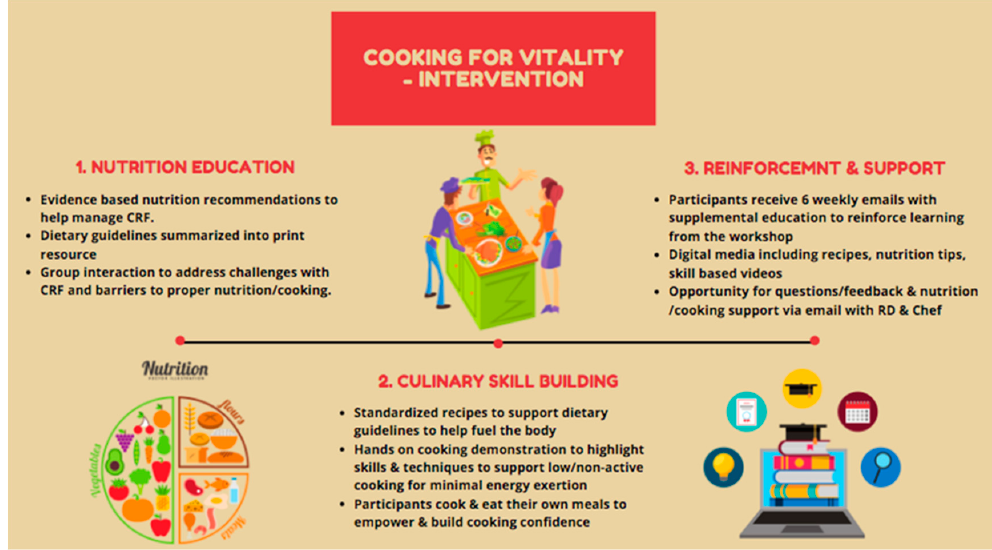
Figure 1. Description of C4V intervention. CRF: Cancer-related